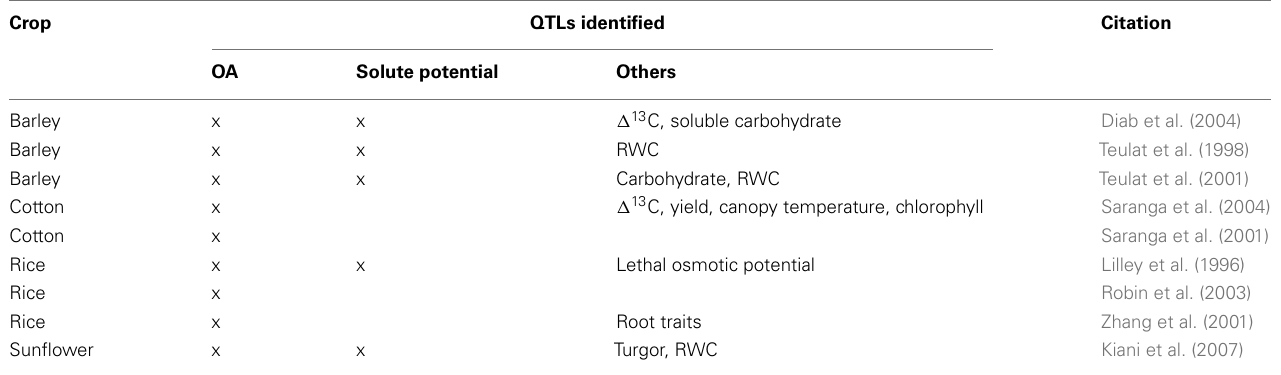
Table 2 | Studies in which QTLs were identified for osmotic adjustment (OA) and related